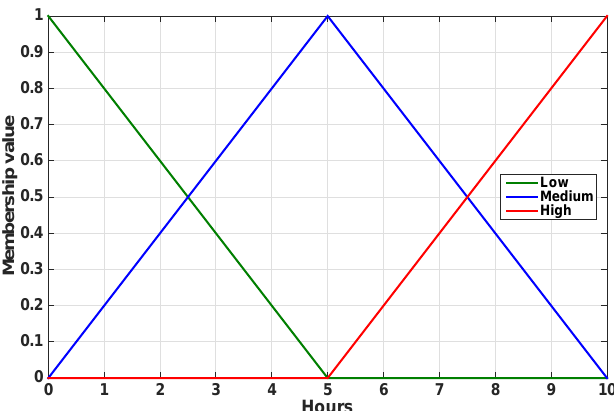
Figure 6. Triangular membership functions for the scheduled time of the input and output parameters for the